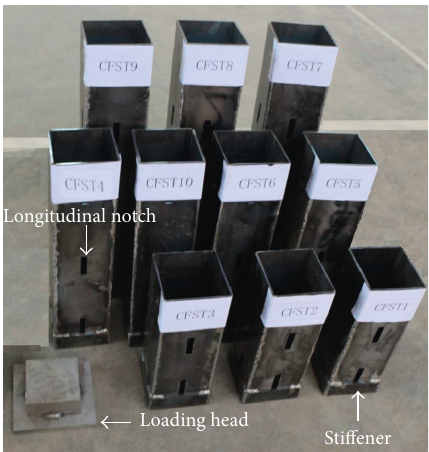
Figure 2: Square steel tubes.